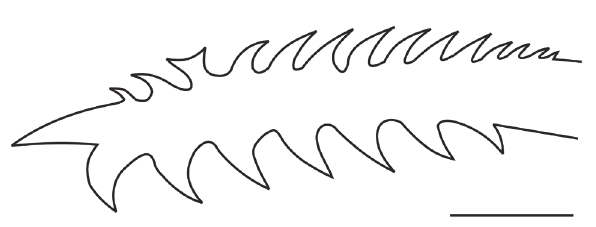
Fig. 6. Left pectoral-fin spine in dorsal view of paratype of Microglanis xylographicus , MZUEL 5174, 26.2 mm SL. Scale bar = 1